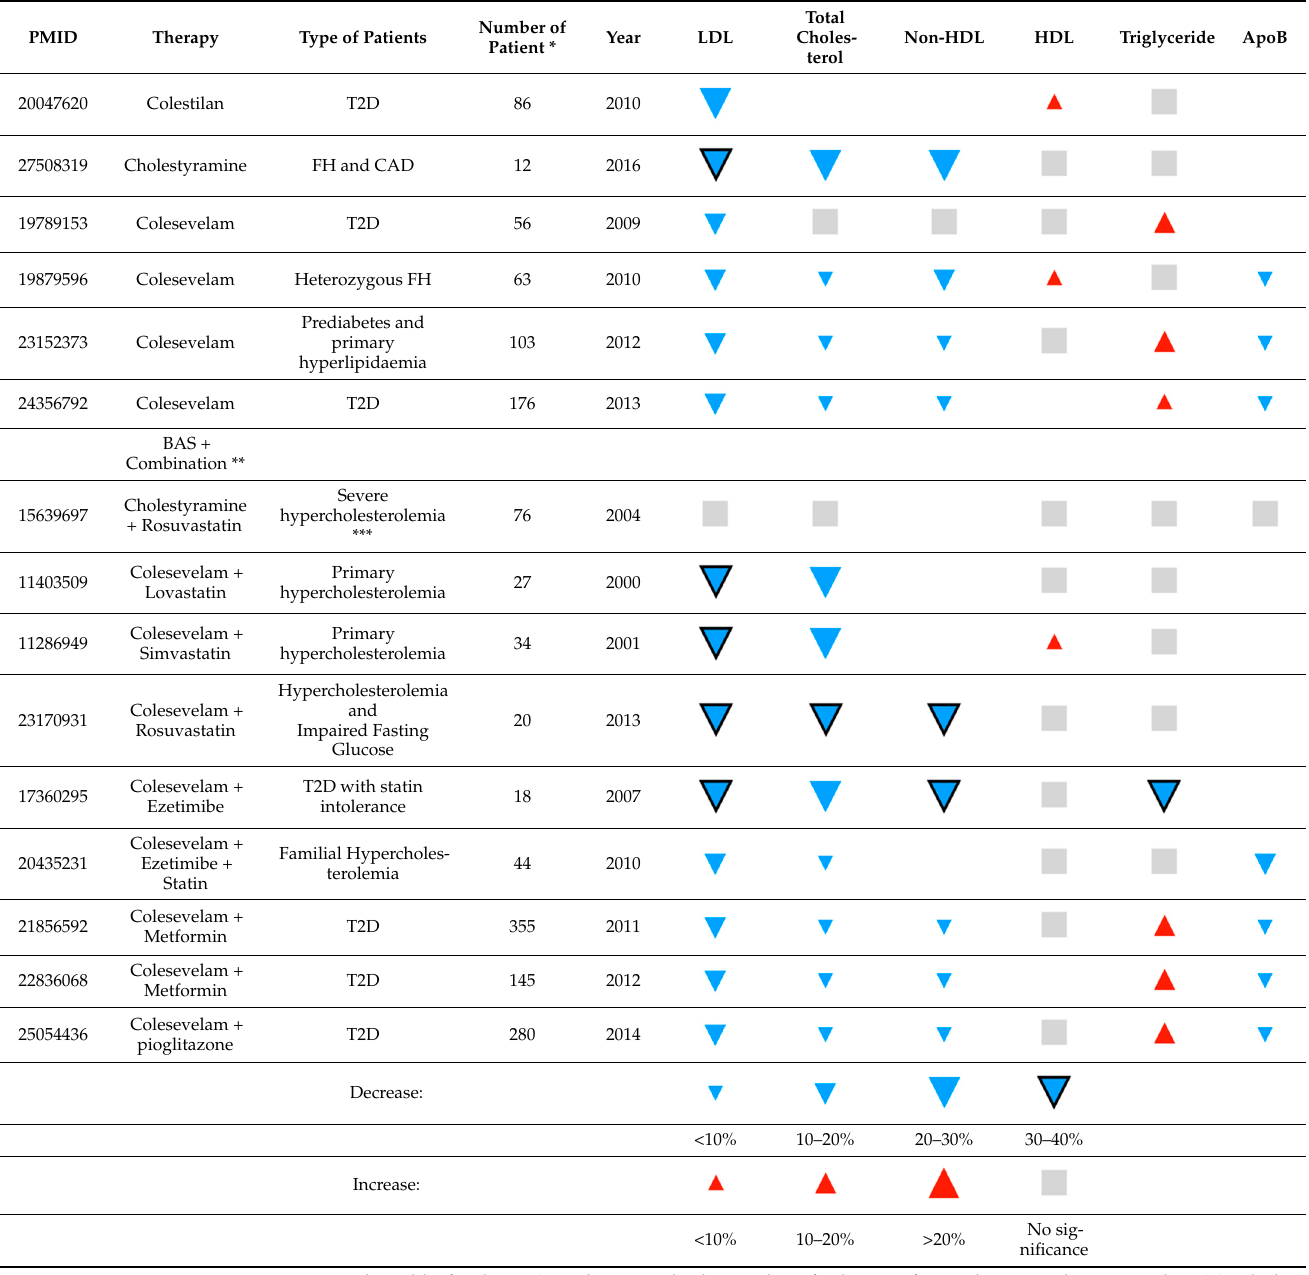
Table 1. Overview of BAS effects on lipid metabolism.